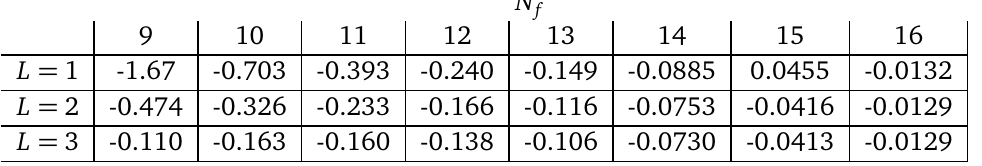
for the QCD-like model at L loops obtained in- −